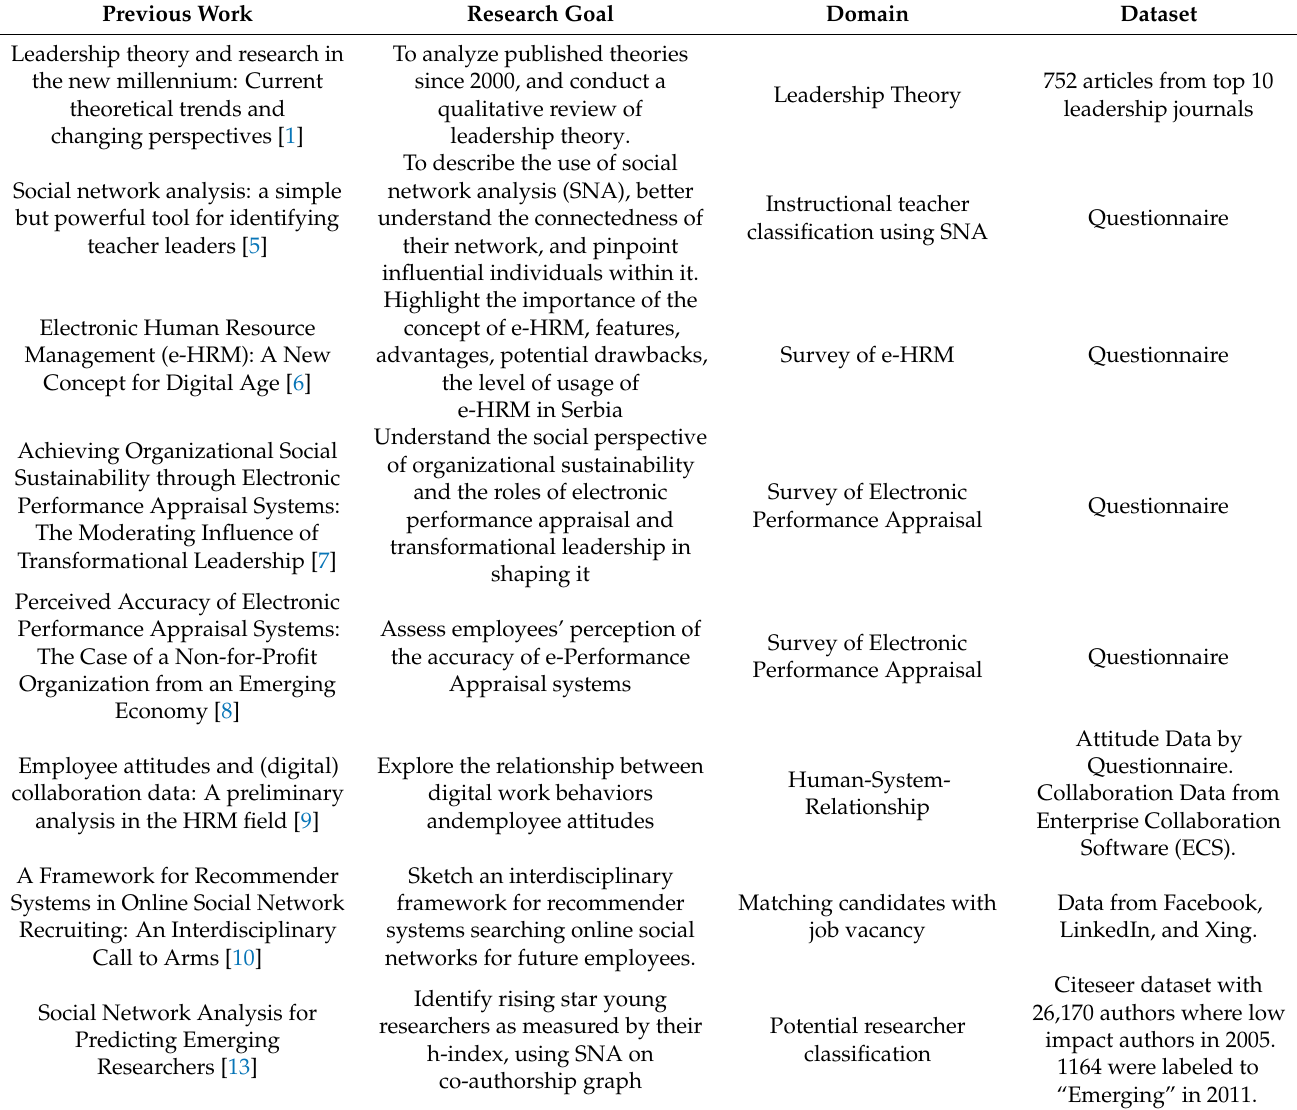
Table 1. Summarization table on the related